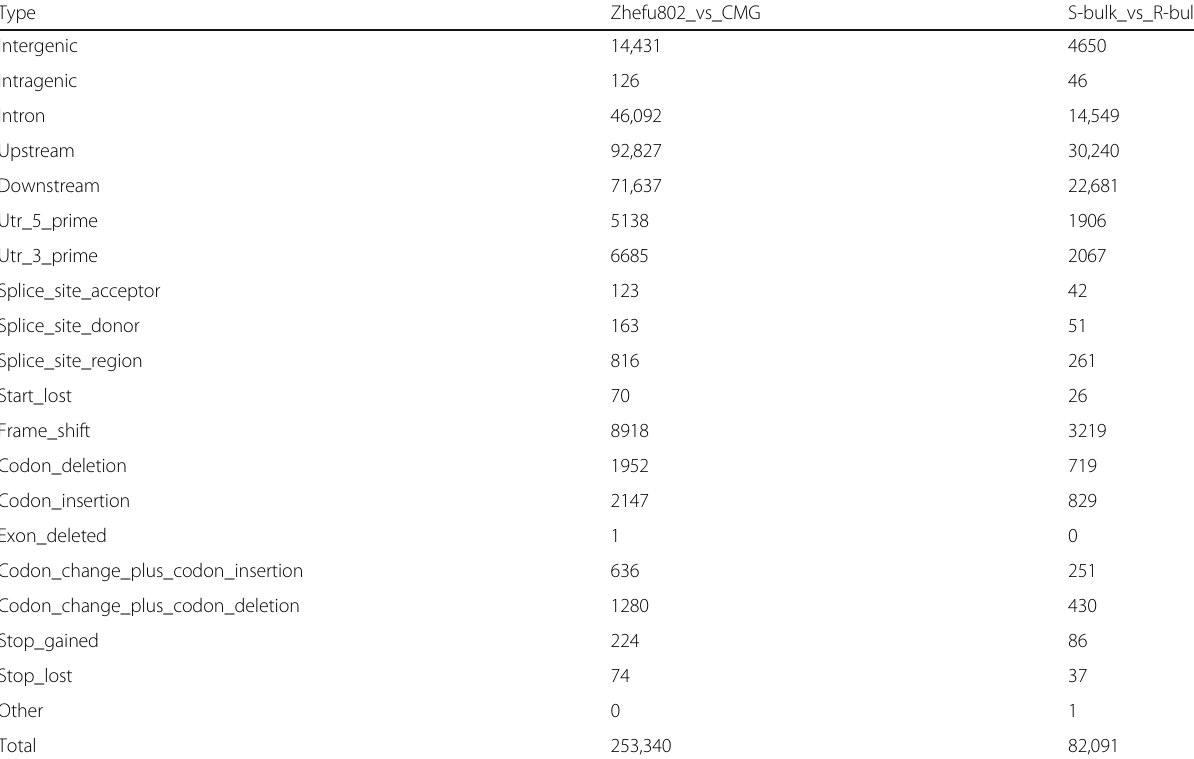
Table 3 The distribution of detected InDels between both parents Zhefu802 and CMG and between the two extreme bulks Type